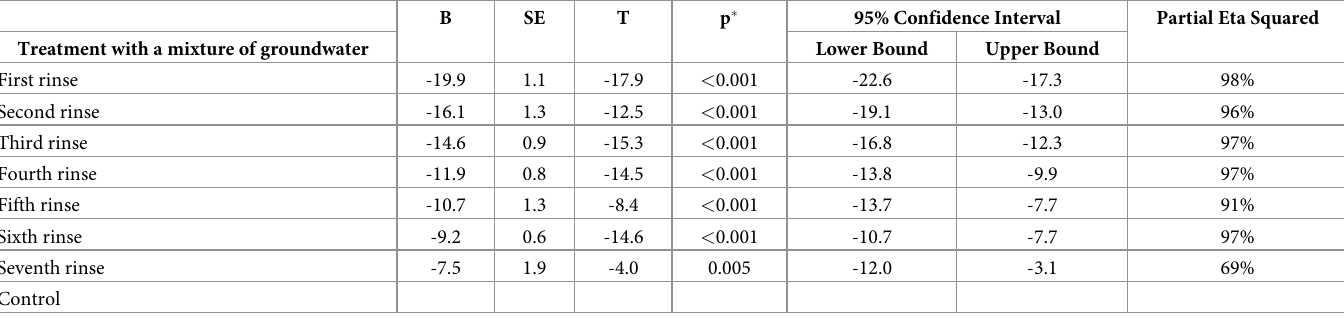
Table 3. Effect of flushing treatment of water and soil mixture at various positions on the decrease in bacterial